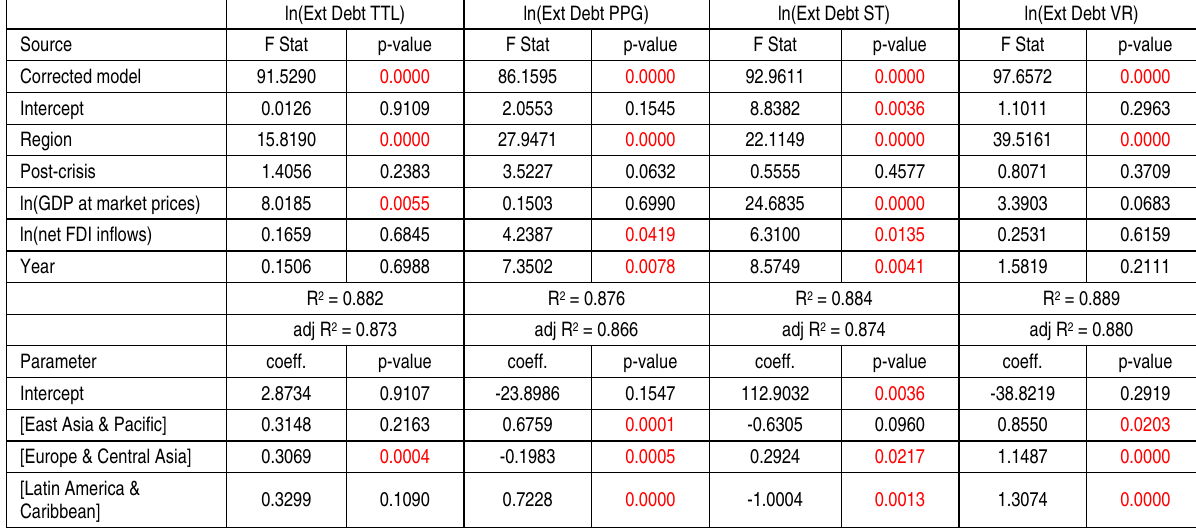
Table 10. Fixed effects panel regression for total external debt, PPG external debt, ST external debt, and VR external